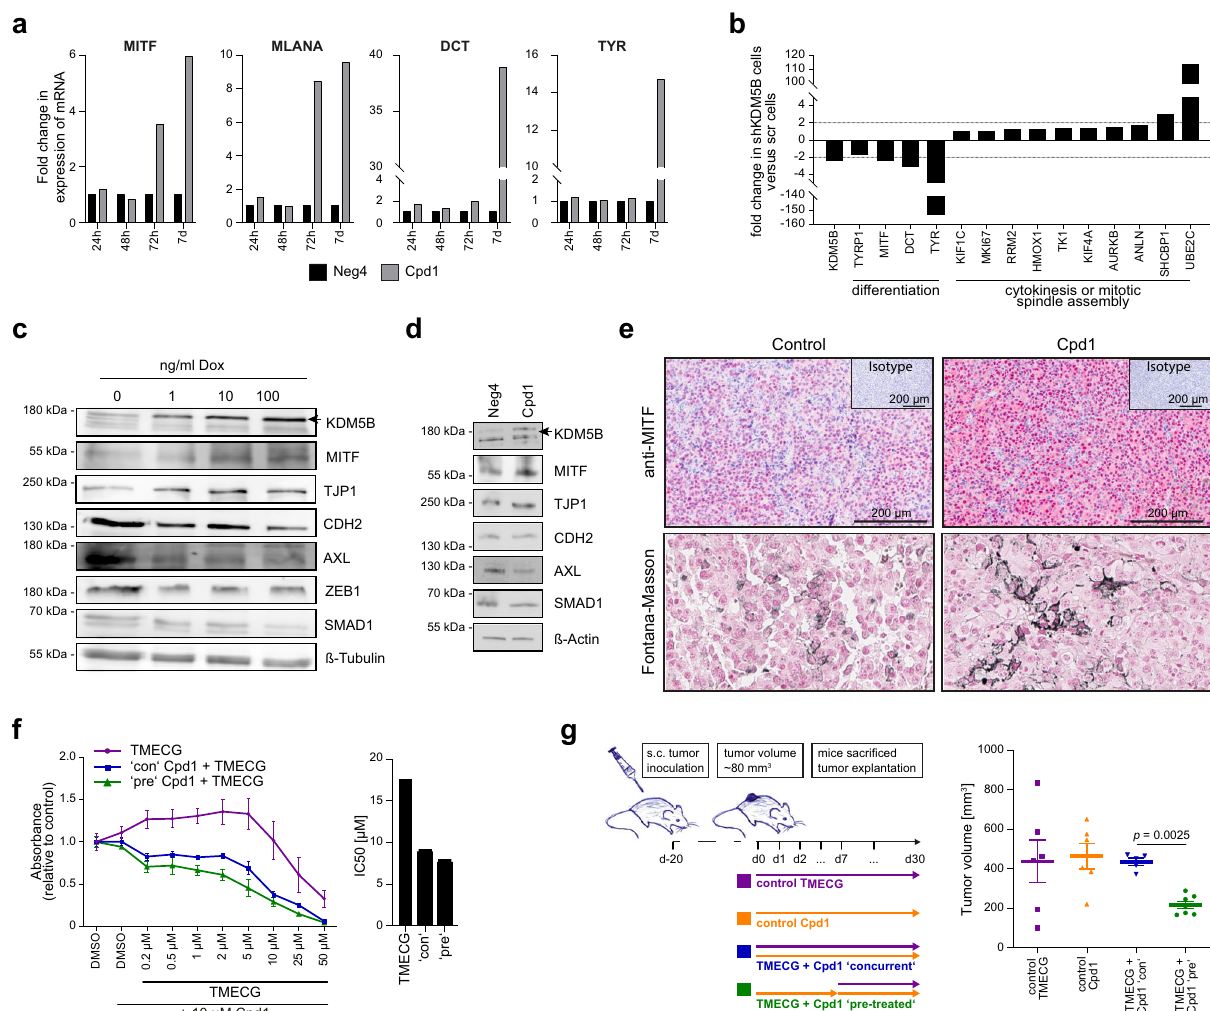
Fig. 6 Enforced KDM5B expression facilitates melanocytic lineage-directed elimination by TMECG. a Quantitation of mRNA after 24h, 48h, 72h and 7 days of Cpd1 treatment of MaMel63a cells as assessed by qPCR. Mean±SD. Shown is one representative example. b Regulation of differentiation, cytokinesis, and mitotic spindle assembly genes as detected by cDNA microarray analysis after KDM5B shRNA knockdown in WM3734 cells ( n = 1). c , d Immunoblotting of melanocytic lineage and (de-)differentiation markers after 24h of KDM5B induction in WM3734 Tet3G-KDM5B cells ( c ) and after 72h of Cpd1 treatment in MaMel63a cells ( d ). Shown are representative data ( n = 2). e Anti-MITF immunostaining (upper panel) and Fontana-Masson staining (lower panels) of CM melanoma tumor grafts from Cpd1-treated vs. control mice. f MTT cell viability assay of WM3734 cells. Representative example is shown left (mean±SD, n = 2) and corresponding IC “ con ” ) or added 3 days after Cpd1 pre-treatment 50 values on the right. TMECG was either concurrently given together with Cpd1 ( ( “ pre ” ). Readout was performed after 72h of TMECG treatment. g Persister-state-directed therapy model in vivo. Left: schematic representation of treatment dosing and timing in immunode fi cient NMRI-(nu/nu)-nude mice. Right: tumor volumes of WM3734 xenografts (endpoint at day 30). TMECG was either